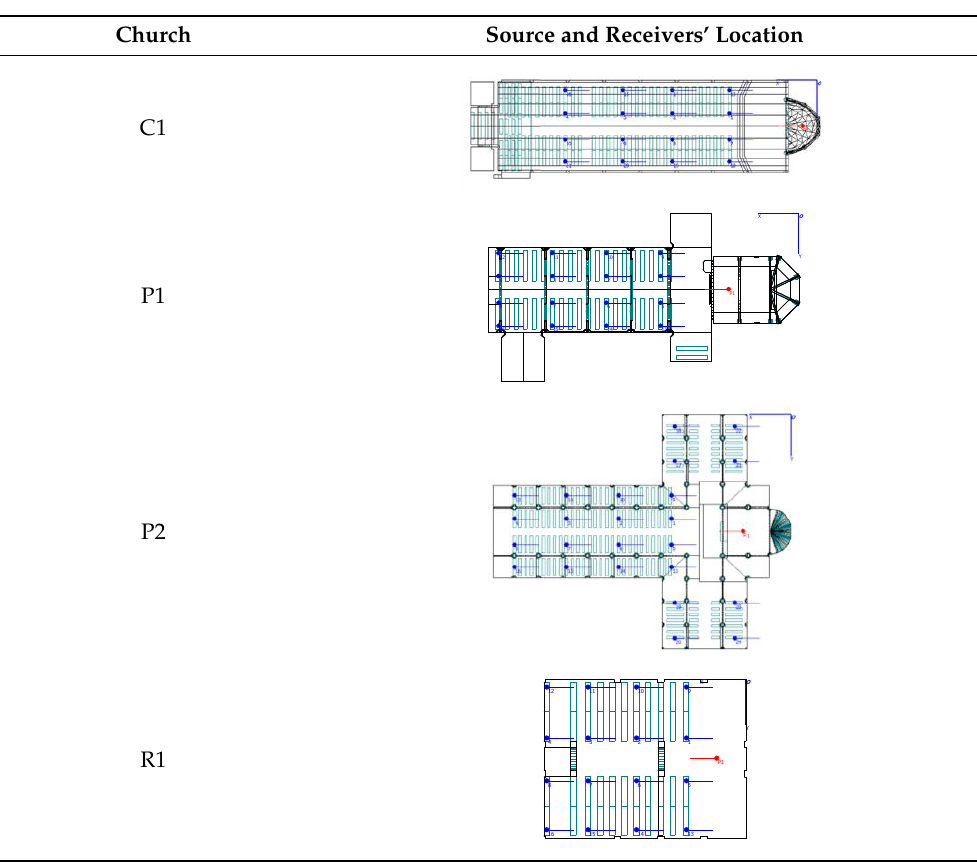
Table 6. Location of the sound source and receivers (red: source; blue: receiver).